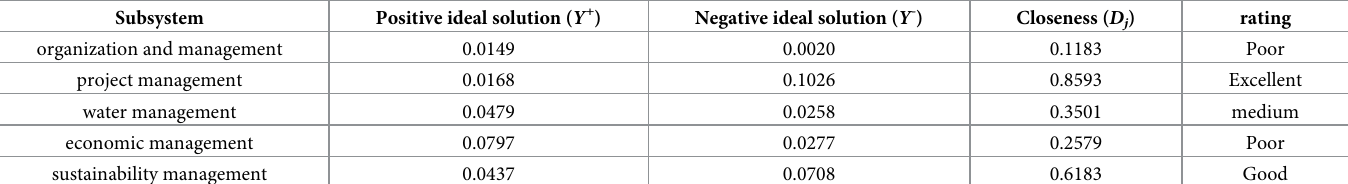
Table 8. Euclidean spatial distances between subsystems and ideal solutions in the water-user association model.